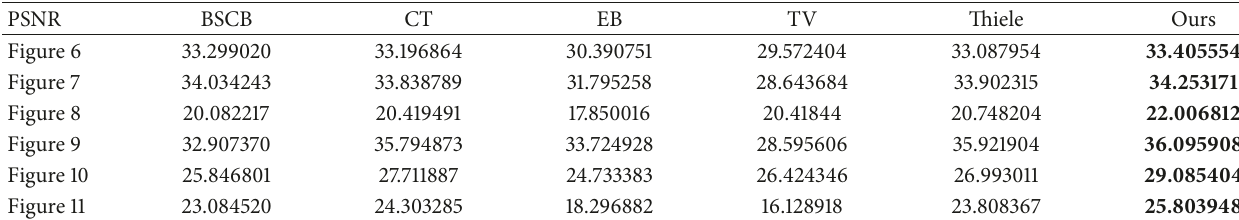
Table 1: The comparison of PSNRs.